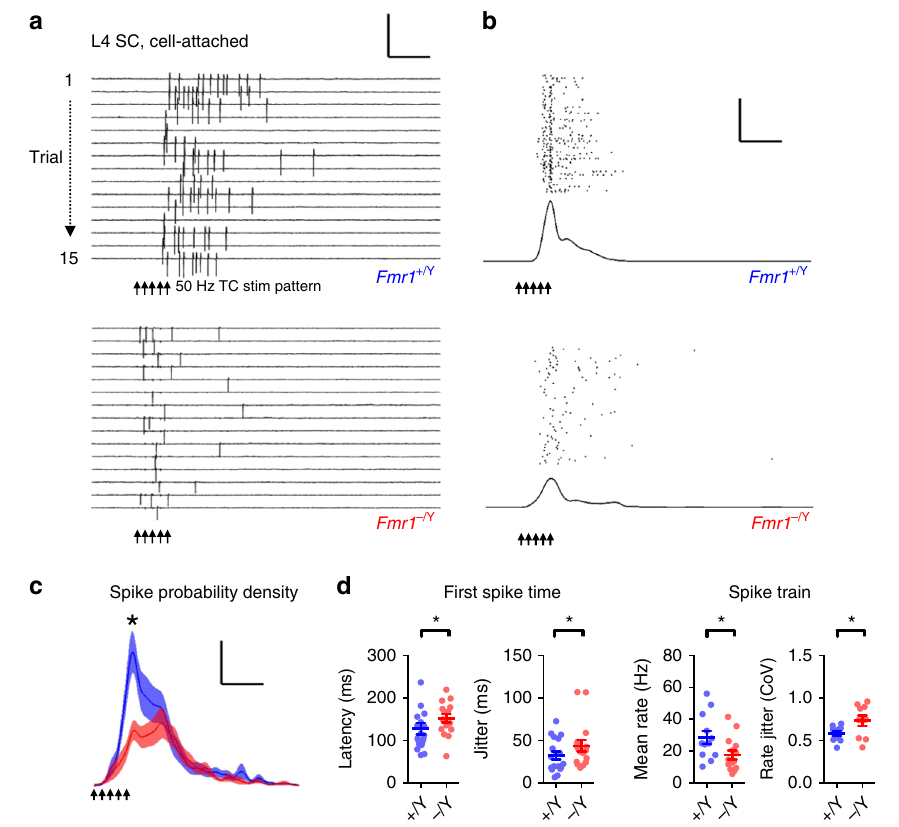
Fig. 6 Low precision spiking of Fmr1-KO Layer 4 excitatory neurons to TC stimulation. a Example multi-trial raster of spikes recorded in cell-attached con fi guration from Fmr1 + /Y (top) and Fmr1 − /Y (bottom) SCs in response to TC-evoked L4 network activity at 50 Hz. Scale: 200 pA/100 ms. b Example calculation of spike density functions for Fmr1 + /Y and Fmr1 − /Y example neurons. Two hundred consecutive trials showing trial-trial variability in the timing of spikes recorded in cell-attached con fi guration (different cells from those shown in ( a )). Bottom: Trial-averaged spike density estimate across trials for neurons shown above. Scale: 50 trials/100ms. c Mean ± SEM spike probability density functions for responding SCs during the peri-stimulus period of TC- evoked network activity. Mean peak spike probability was reduced in Fmr1 − /Y recordings, calculated across the whole 1 s post-stimulus sampling period ( Fmr1 + /Y : 0.023 ± 0.002 sipkes s − 1 , vs. Fmr1 − /Y : 0.015 ± 0.0016 spikes s − 1 , p = 0.008, t -test, N : Fmr1 + /Y : 21 neurons, Fmr1 − /Y : 16 neurons). Mean spike density averaged across the successive 200 ms window of was not signi fi cantly different between genotypes ( t -test, p = 0.7). Scale: p(spike/5 ms) = 0.5%/100ms. d Left: Spike-time statistics for the fi rst spike fi red per trial for SCs. Mean latency (left) and inter-trial precision (right) were signi fi cantly slower and reduced in Fmr1 − /Y neurons ( p = 0.01 and p = 0.03, respectively. t -test, N ’ s as in ( c )). Right: Spike rate and rate stability was signi fi cantly different in Fmr1 − /Y recordings compared with Fmr1 + /Y littermates: SCs fi red at rates that were slower and more variable between trials. Plotted points are individual neurons, bars show mean ± SEM values. Asterisks indicate statistically signi fi cant differences between genotypes ( p < 0.05, t -test, N ’ s as in ( c